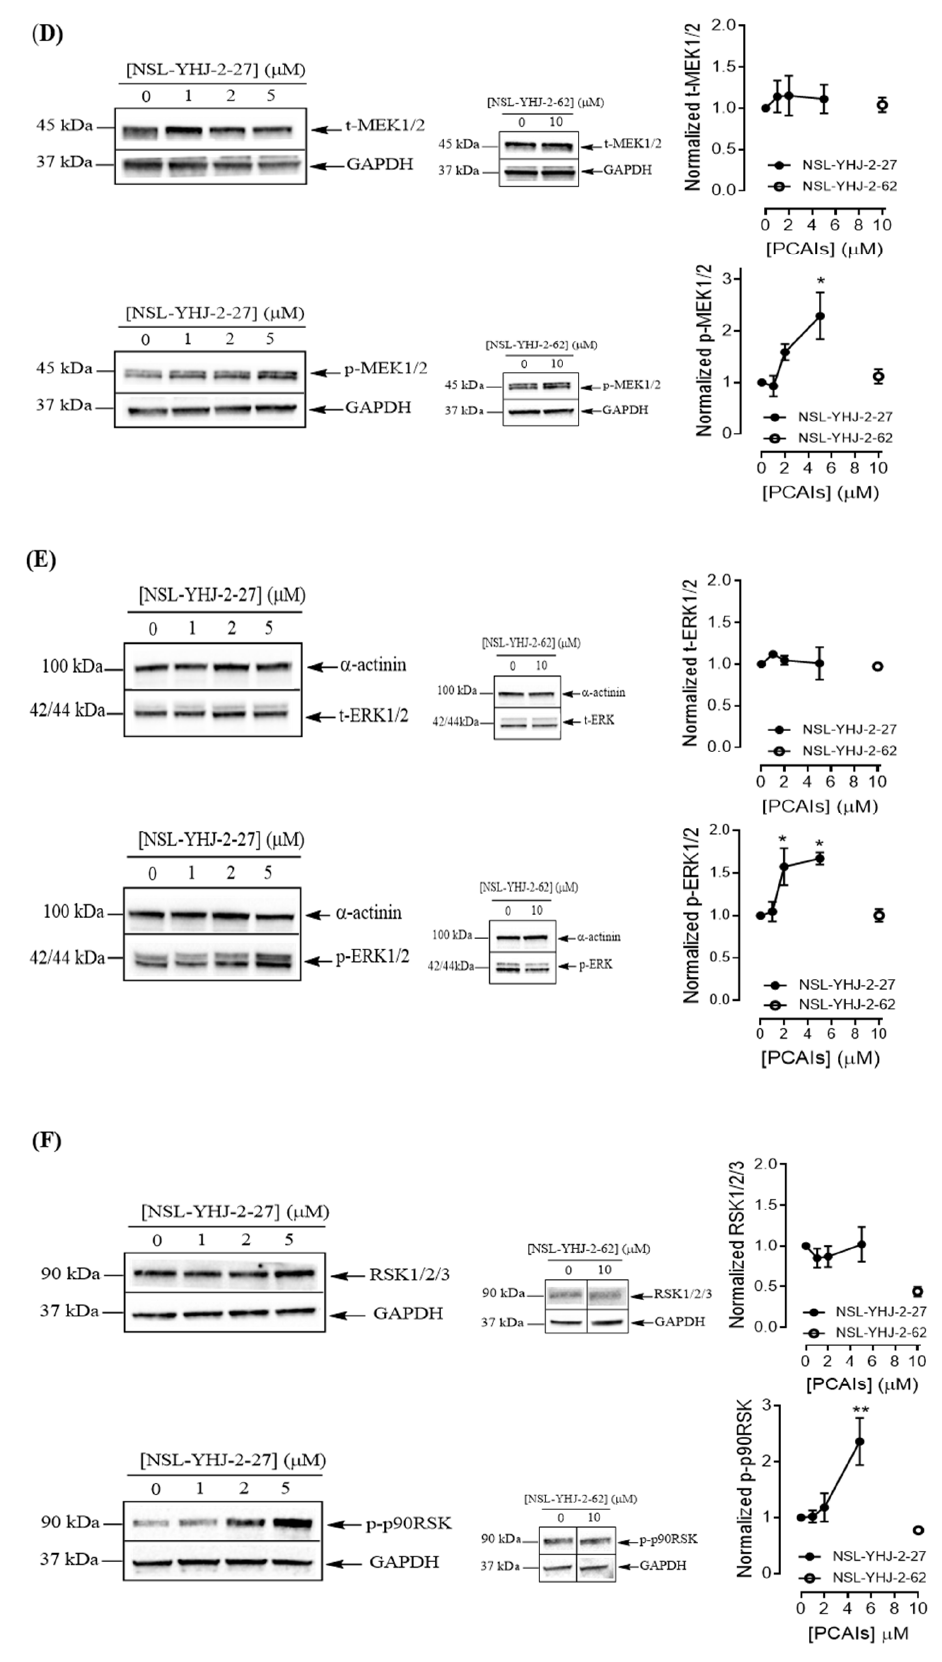
Figure 6. PCAIs activate the MAPK pathway in A549 lung cancer cells. A549 cells were treated for 48 h with 0 − 5 µM of NSL-YHJ-2-27 or 10 µM of NSL-YHJ-2-62. These were then lysed and subjected to western blot analysis for total and phosphorylated levels of MAPK pathway proteins. ( A ) Shows treated cells captured using the Nikon Eclipse Ti 100 inverted microscope at 10× magnification just before lysis for western blotting analysis. (B-F) Western blot images and densitometry plots of bands